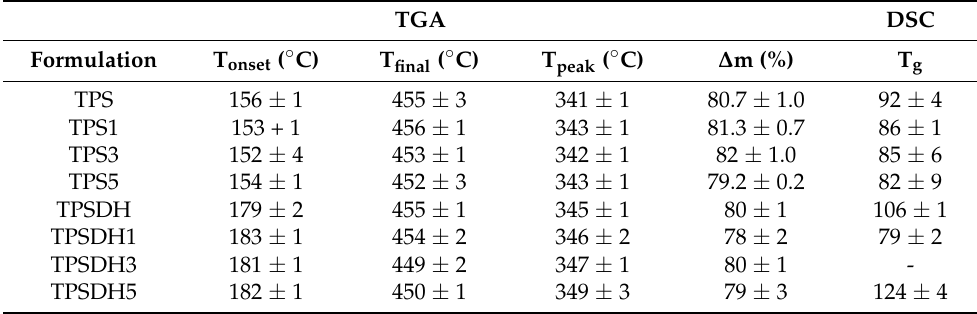
heating (TPSDH) films with different contents of cellulose microfibers (CMFs).